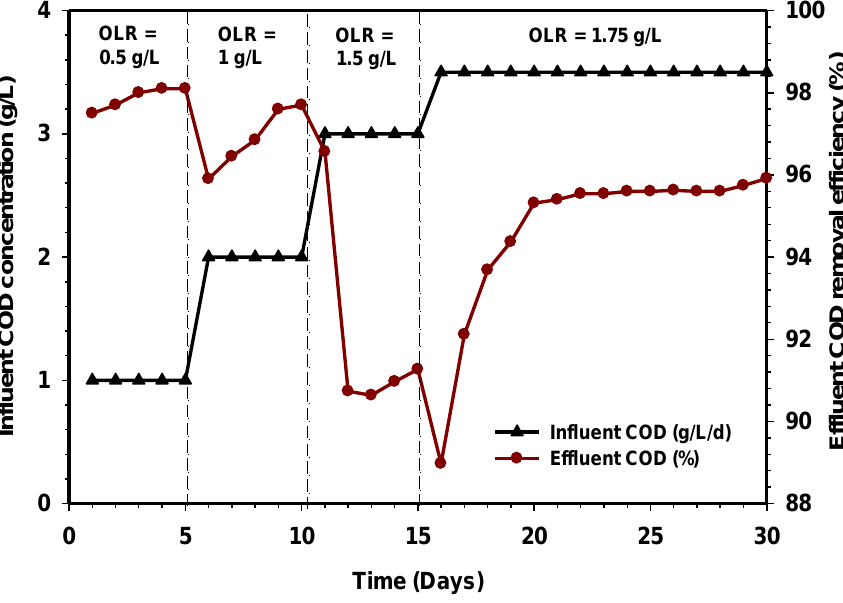
Figure 2. Acclimation period relative to COD removal efficiency.